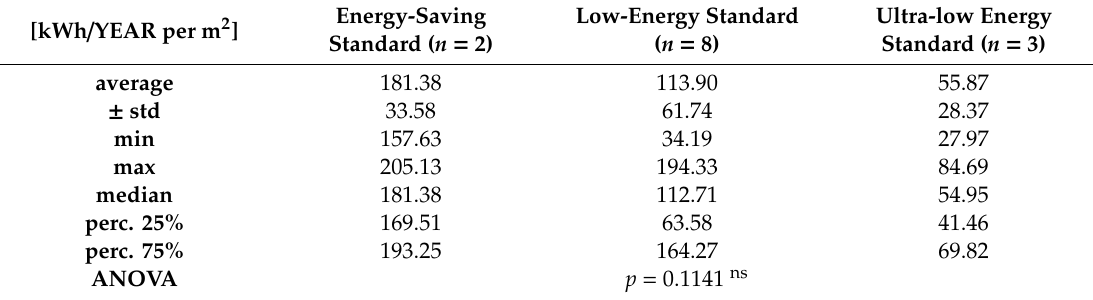
Table 8. Annual energy demand for heating categorized according to energy standards calculated per m 2 of useful floor area of the analyzed log wood constructions.